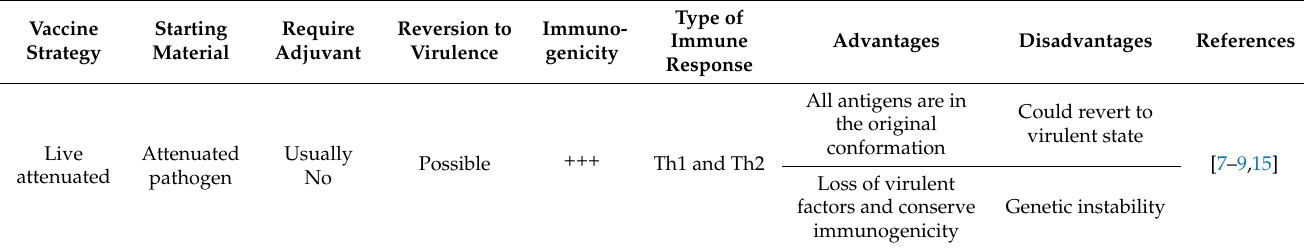
Table 1. Features, advantages and disadvantages of available vaccination approaches for animal viral diseases. Vaccine